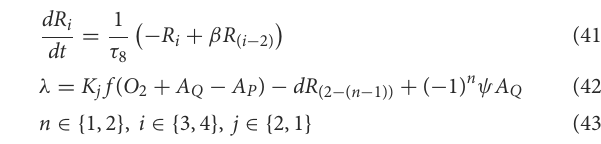
adaptation ( A Q ). Our aim is to prolong this behavior over time. The projections of this stage continue to the nonlinear oscillation generator circuit. In this circuit, a left-turn adaptation unit is added again with the intention of increasing the difference between the widths of the oscillations and generate a torque that allows to change the orientation of the robot. The mathematical representation is given in Equations (36)–(39).